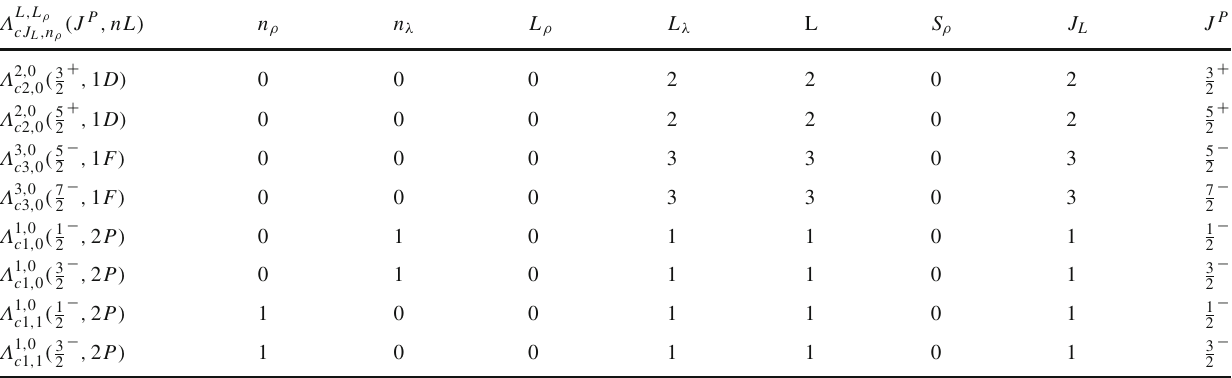
Table 1 Possible Λ c decaying into DN final states Λ L , L ρ ( J P , nL ) cJ L , n ρ